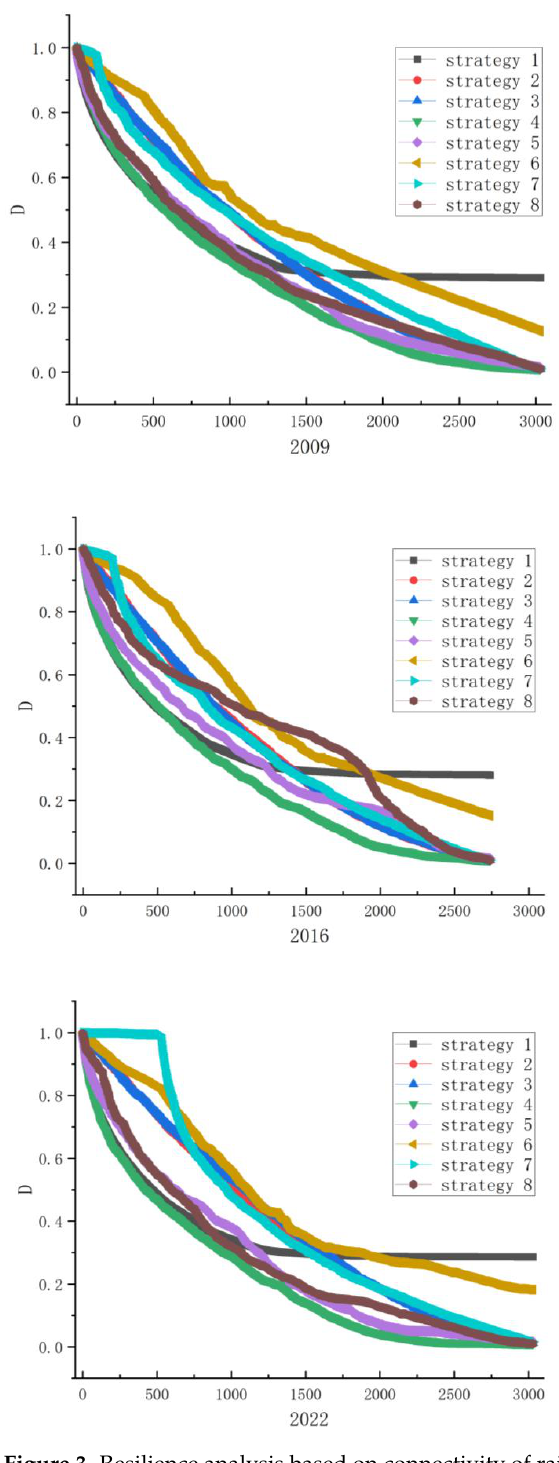
Figure 3. Resilience analysis based on connectivity of rail transit